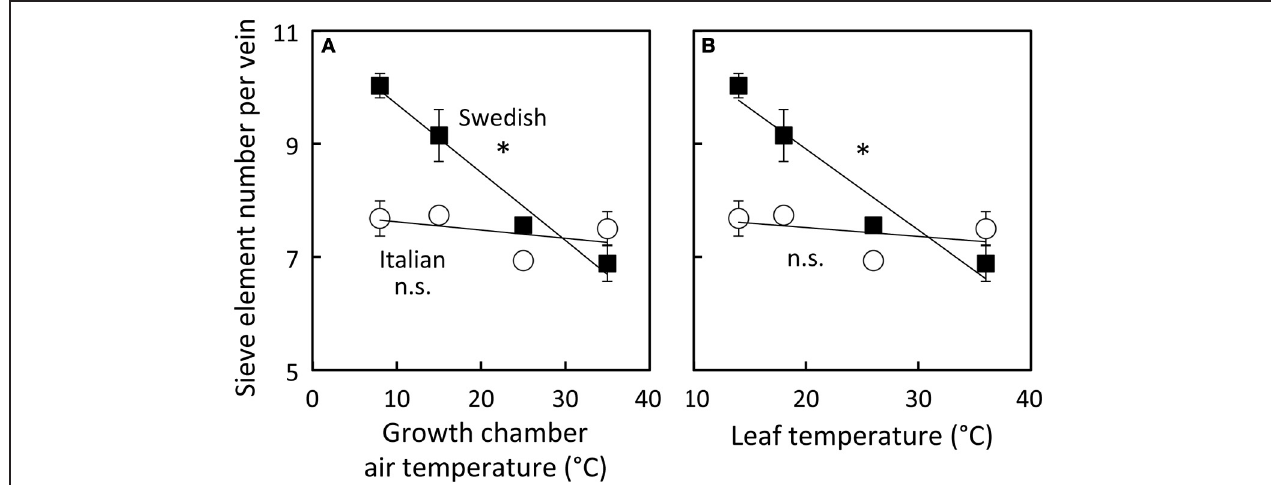
FIGURE 9 | Differences in sieve element number per minor loading (third- and fourth-order) vein among Italian (open circles) and Swedish (black squares) ecotypes of A. thaliana dependent on air temperature (A) or leaf temperature (B) during growth under moderate light (400 µ mol photons m − 2 s − 1 ). Means ± standard error